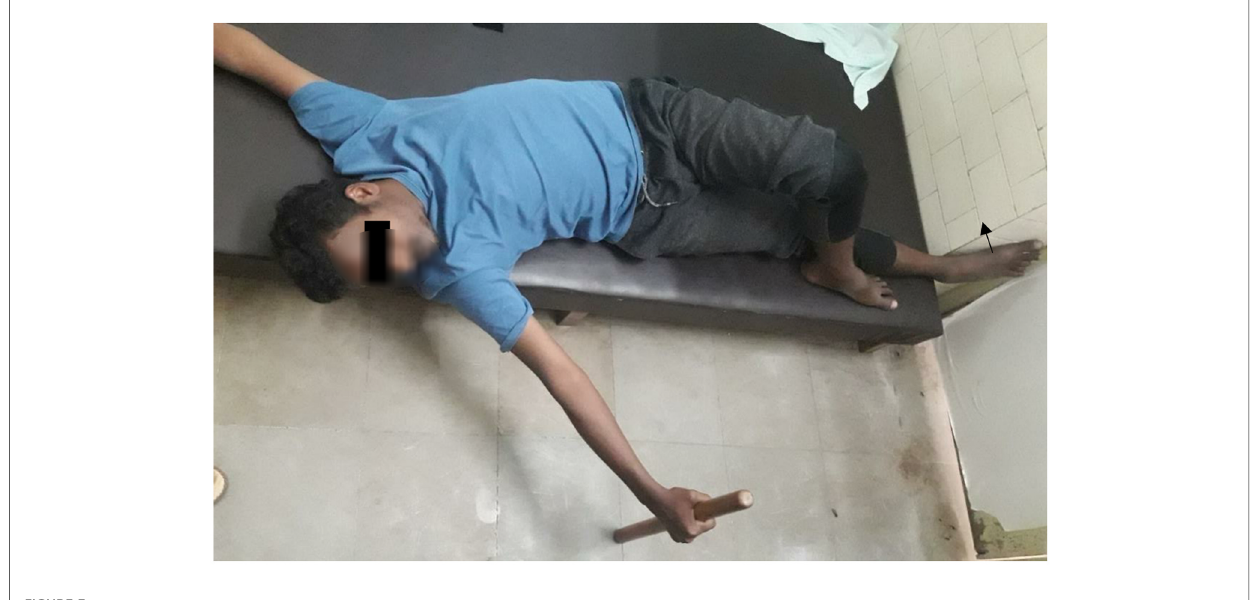
FIGURE 3 Curve speci fi c correction in